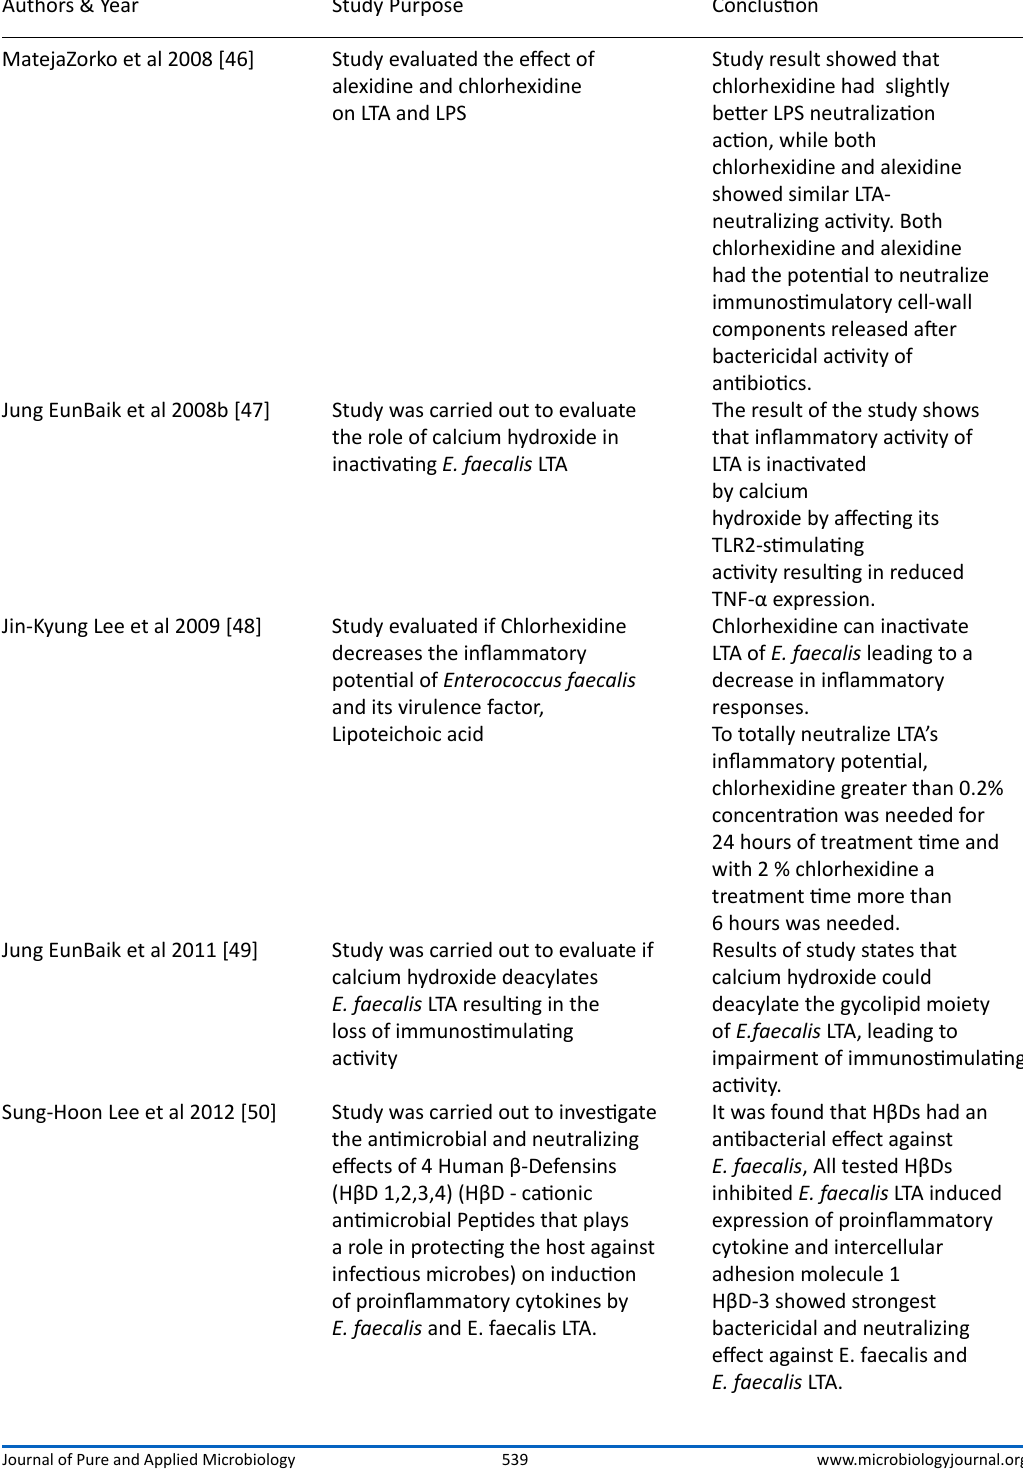
Table 1. Summary of studies carried out to evaluate LTA neutralizing action by various therapeutic agents used Authors &